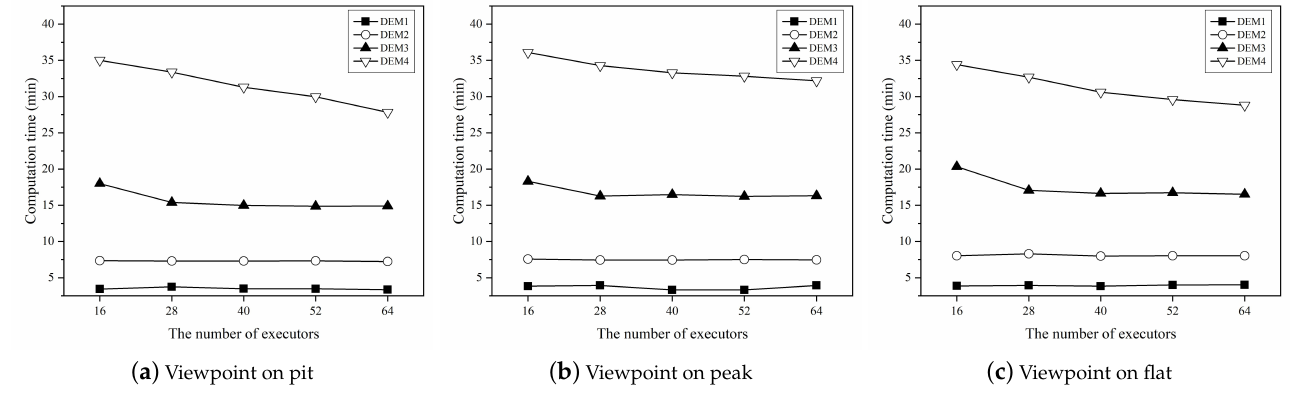
Figure 15. Comparisons of the computation time of different number of